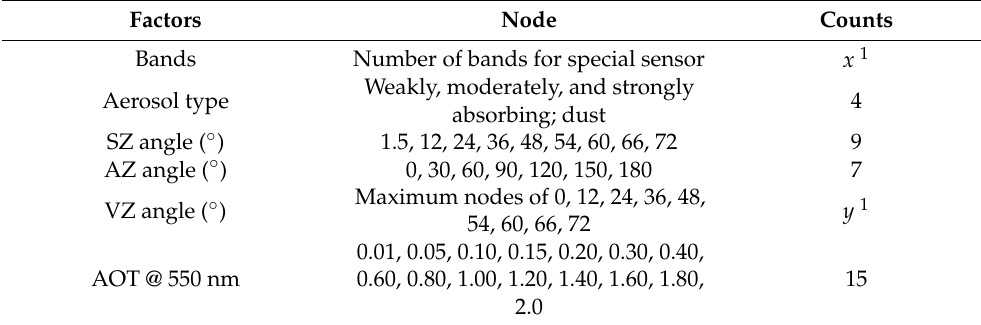
Table 2. Dimensionality and LUT